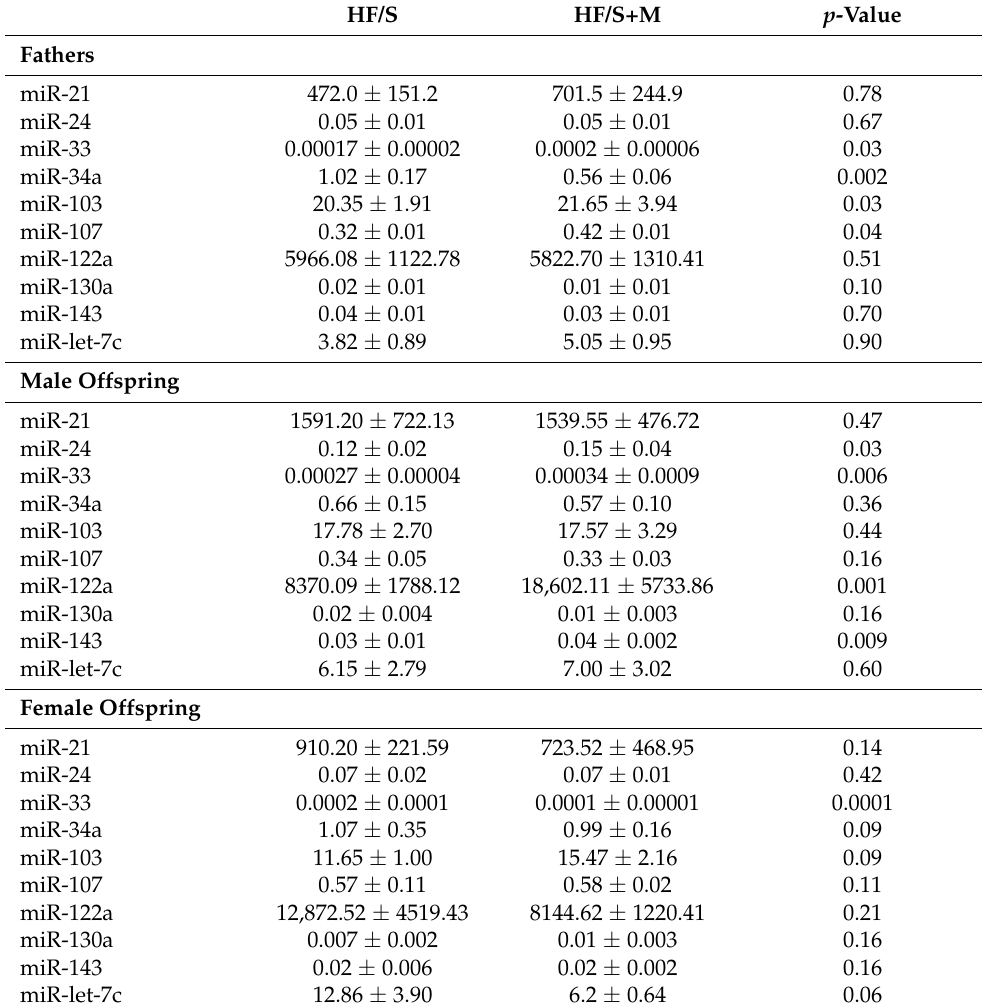
Table 3. MicroRNA expression in liver